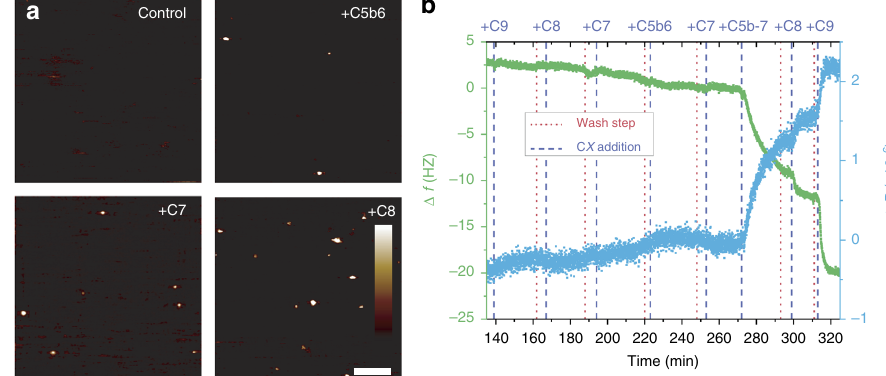
Fig. 2 C5b-7 initiates MAC formation and recruits C8 and C9 directly from solution. Binding of complement components C5b6, C7 and C8 to supported bacterial model membranes containing PG lipids, as observed by AFM and QCM-D. a AFM images increasingly show protruding features upon addition of C5b6, C7 and C8 to a bilayer formed of DOPE:DOPG (50:50 mol%). Scale bar: 200 nm, height scale: 1 nm. b QCM-D binding assay following the addition of complement proteins, in reverse sequence followed by the forward sequence, to a lipid bilayer formed of DOPC:DOPE:DOPG (47.5:47.5:5 mol%) on a silicon dioxide coated QCM-D sensor. In isolation, complement proteins C7, C8 and C9 do not bind to the membrane, requiring C5b6 to initiate the interaction. Distinct steps in both frequency ( Δ f ) and dissipation ( Δ D ) upon sequential addition of C5b-7, C8 and C9 demonstrate protein binding to the membrane; wash steps (denoted by dotted red lines) between additions do not lead to a reduction in the signal size, revealing that the protein binding is stable. The dissipation shift increases upon binding, re fl ecting the relative softness of the protein complexes in the lipid bilayer fi